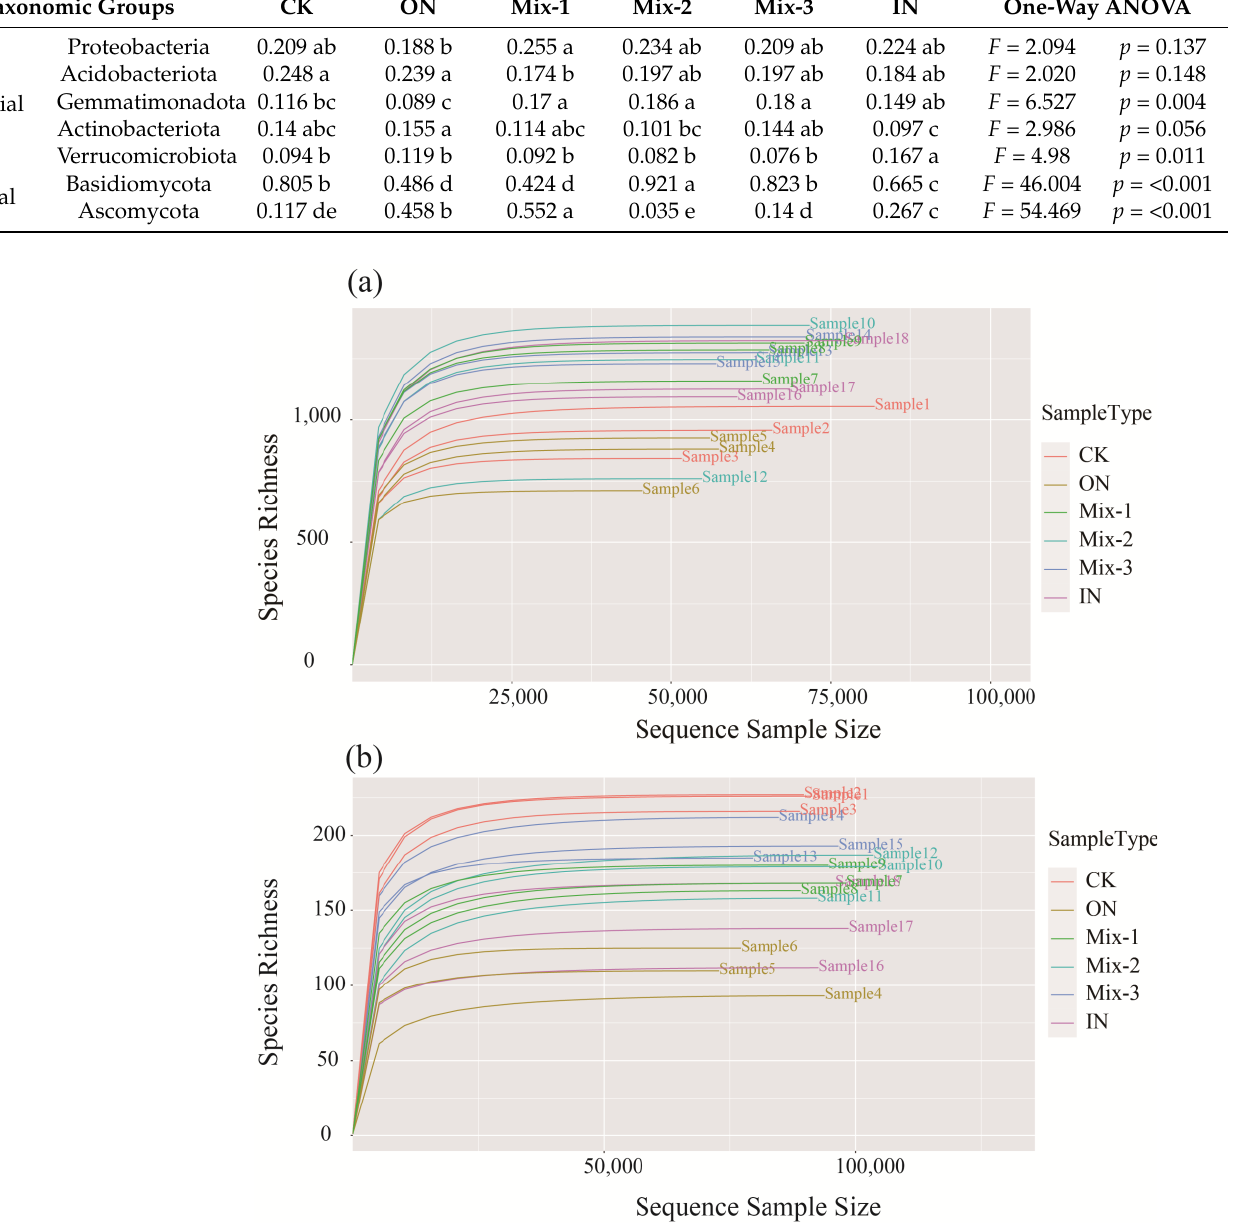
Figure A1. Observed species rarefaction curves of the bacteria ( a ) and fungi ( b ) under different treatments.